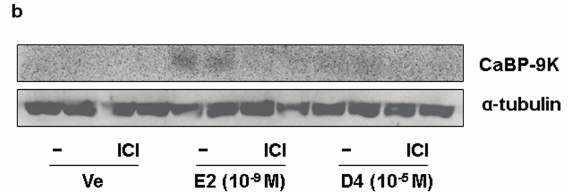
Figure 1. CaBP-9K expression in GH3 cells at the mRNA ( a ); and protein ( b ) levels. Results presented in the bar graph are divided according to chemical administered and subdivided according to the presence or absence of ICI 182 780. Ve, vehicle; E2, 17 β - estradiol; D4, octamethylcyclotetrasiloxane. a p < 0.05 vs. vehicle; b p < 0.05 vs. without ICI. Data are presented as the mean ± SD.